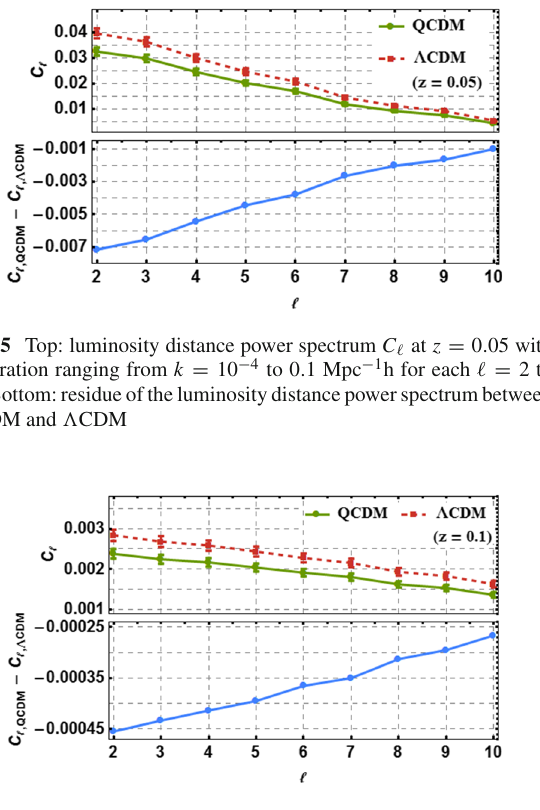
Fig. 6 Top: luminosity distance power spectrum C (cid:11) at z = 0 . 1 with integration ranging from k = 10 − 4 to 0 . 1 Mpc − 1 h for each (cid:11) = 2 to 10. Bottom: residue of the luminosity distance power spectrum between QCDM and (cid:4)